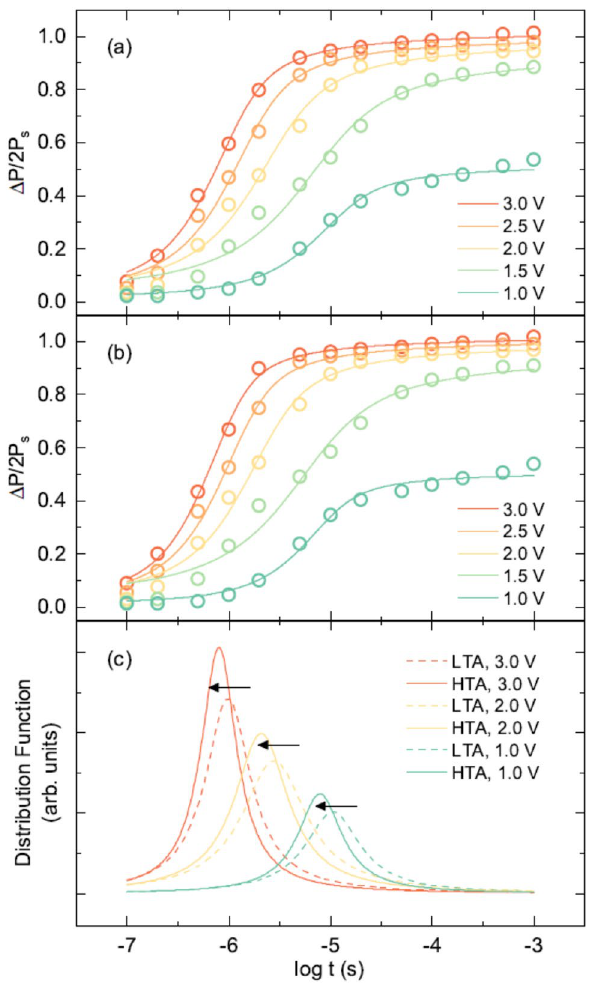
Figure 4. Ferroelectric switching dynamics of the HfO 2 films. Time and voltage dependence of the ΔP(t)/2P s values of the ( a ) LTA and ( b ) HTA films. The solid lines represent the fitting results obtained using the NLS model with a Lorentzian distribution of the characteristic switching time. ( c ) Fitting results of the Lorentzian distribution of the characteristic switching time for LTA (dashed lines) and HTA (solid lines)